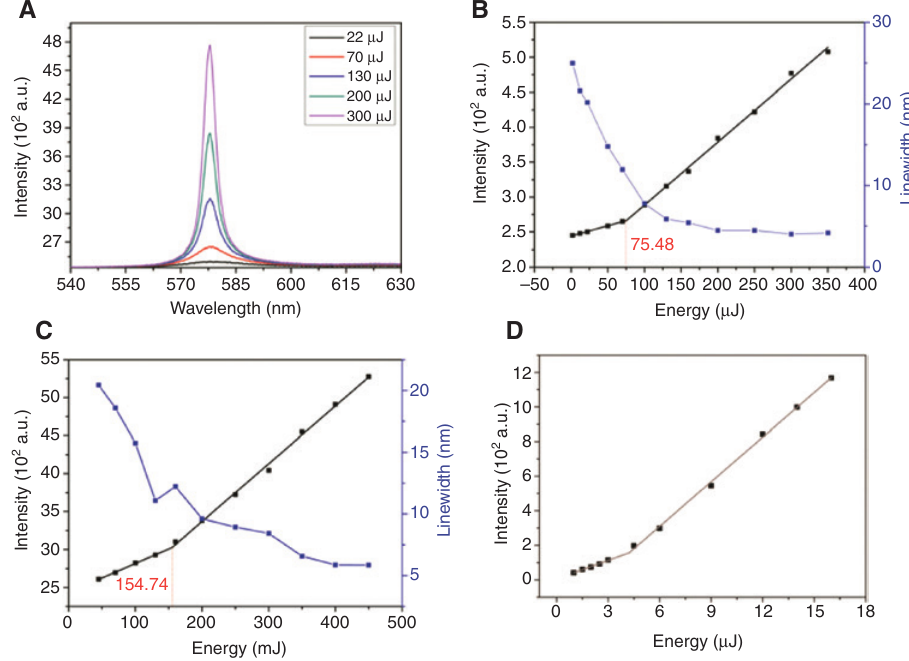
Figure 5: Random laser properties observed in the polymer films using dip-coating method. Emission spectra of PSPP (A) with different pumping energy; integrated emission intensity and corresponding FWHM as function of pumping energy for PSPP (B), PSCP (C) and PSPM